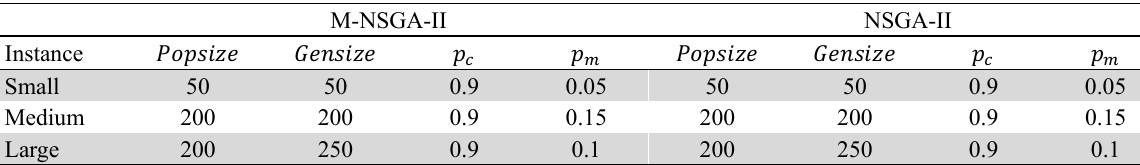
Parameter values for M-NSGA- Ⅱ and